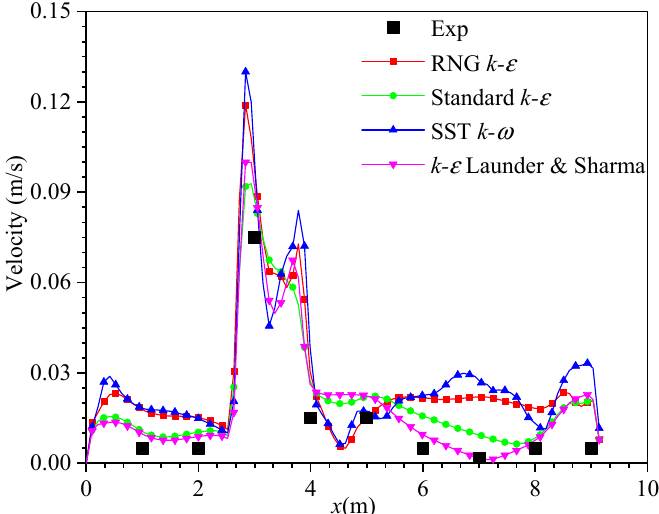
Figure 5. Comparison of simulation results of turbulence model with experimental data ( z = 1.6 m).